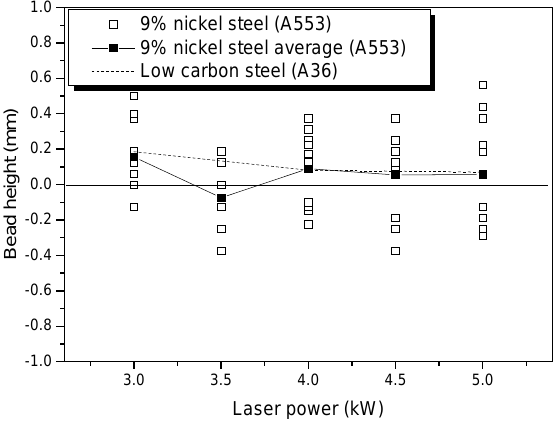
Figure 9. Height fluctuation of surface beads, according to laser power.